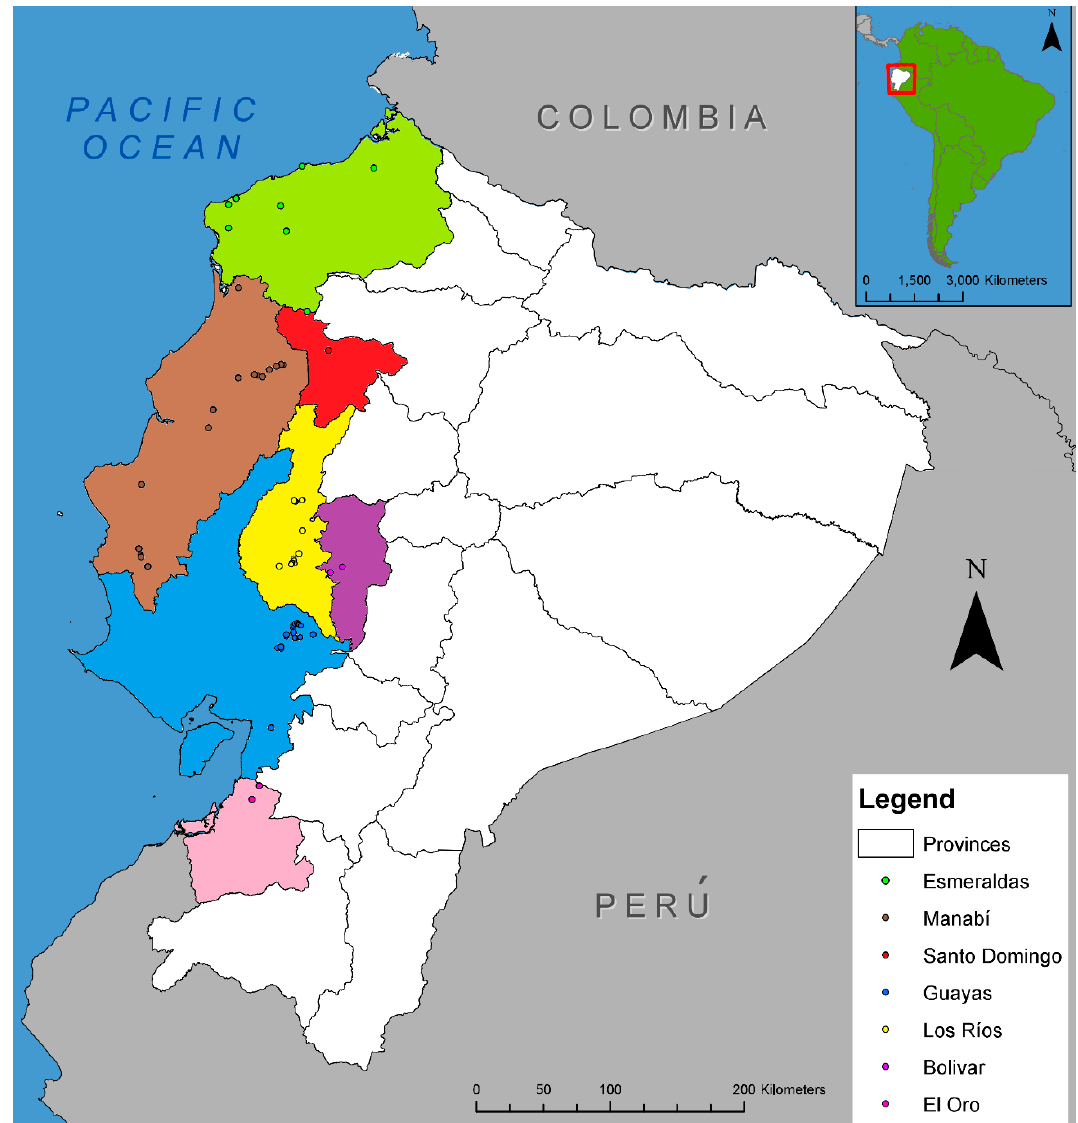
Figure 1. Distribution map showing sampling sites of Fusarium wilt of banana observed across the coastal area of Ecuador. Colored dots represent locations visited in seven provinces of Ecuador (Esmeraldas, Manabí, Guayas, Los Ríos, El Oro, Bolívar, and Santo Domingo).